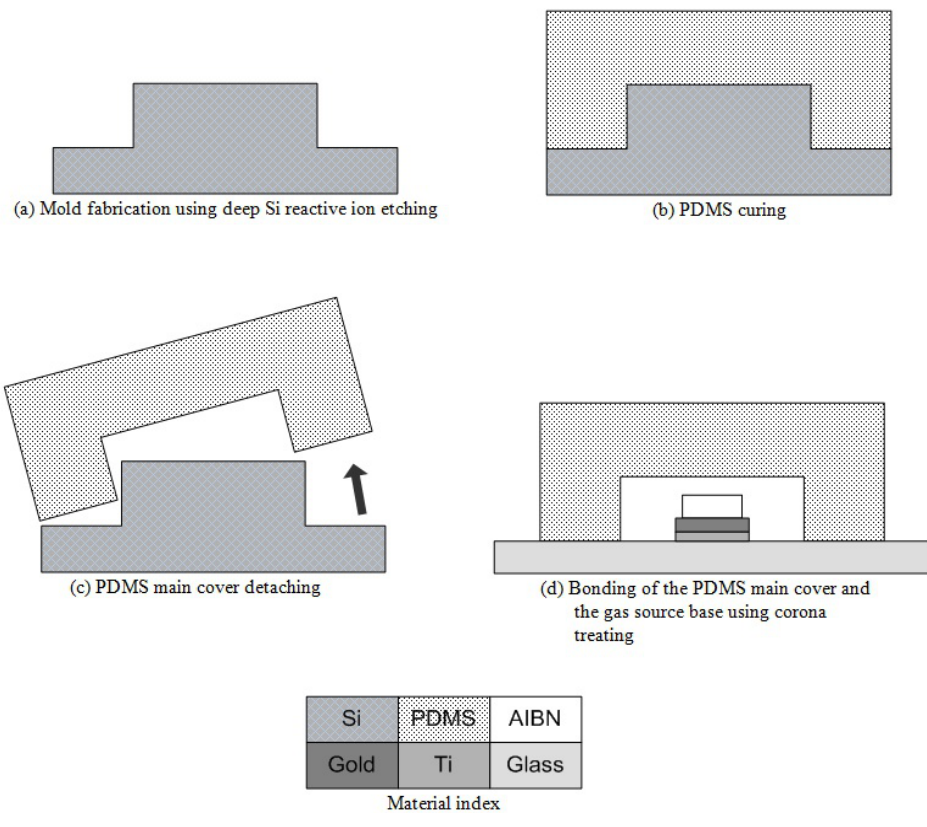
Figure 5. The fabrication process flow of the PDMS gathering tool.